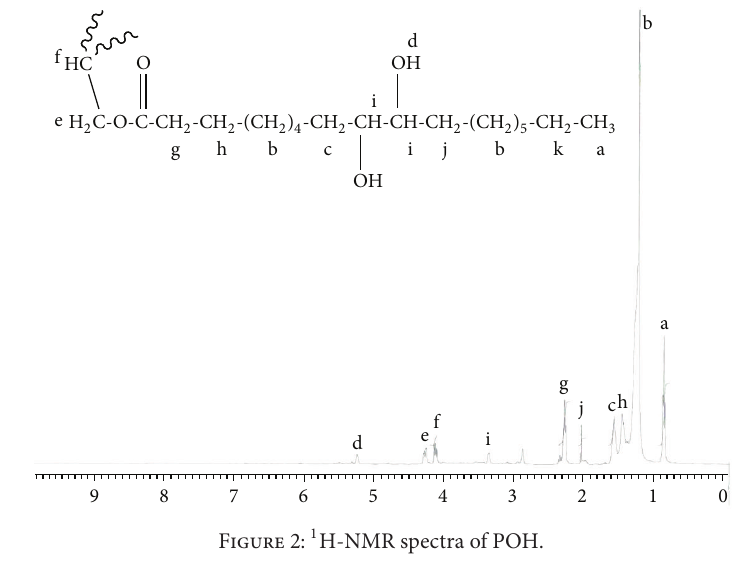
Figure 2: 1 H-NMR spectra of POH.